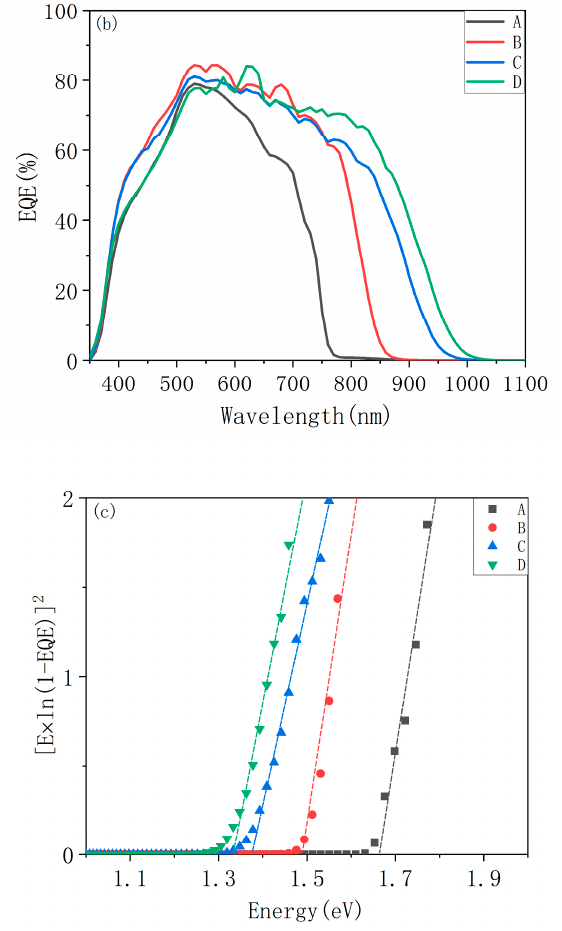
Figure 4. ( a ) The J-V curve of CIGS cells using CdS as buffer layer, ( b ) their corresponding EQE spectra, and ( c ) the minimum band gap obtained from the EQE curve. Table 4. The band gap of CIGS measured by EQE and